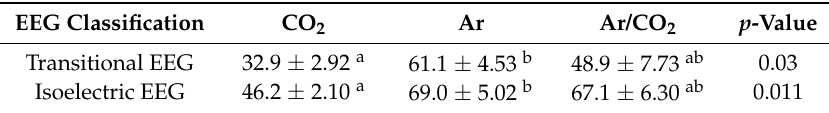
Table 3. Mean (± SEM) latency (seconds) to the appearance of transitional and isoelectric electroencephalogram (EEG) in piglets during gas euthanasia with 100% carbon dioxide (CO 2 , n =